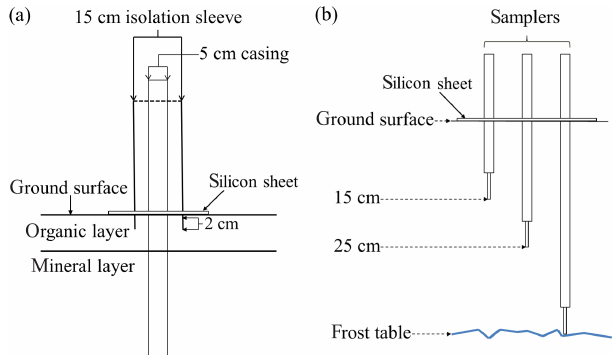
Figure 4. (a) Schematic representation of the observation wells with isolation sleeve and (b) a schematic representation of a Rhizon sam- pling